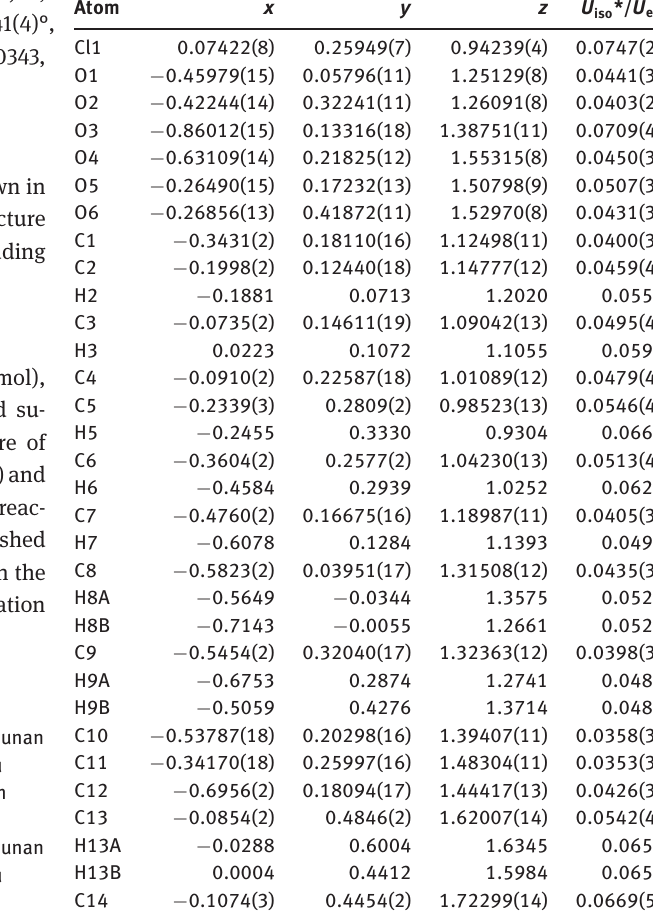
Table 2: Fractional atomic coordinates and isotropic or equivalent isotropic displacement parameters (Å 2